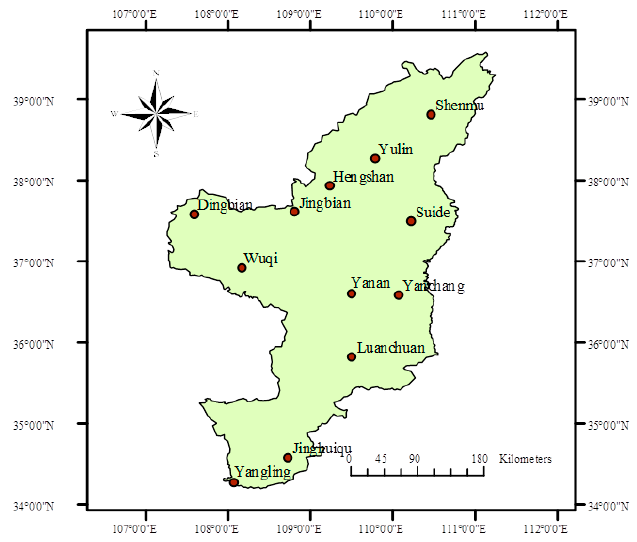
Figure 1. The geographical location of the maize crop sites of Shaanxi.